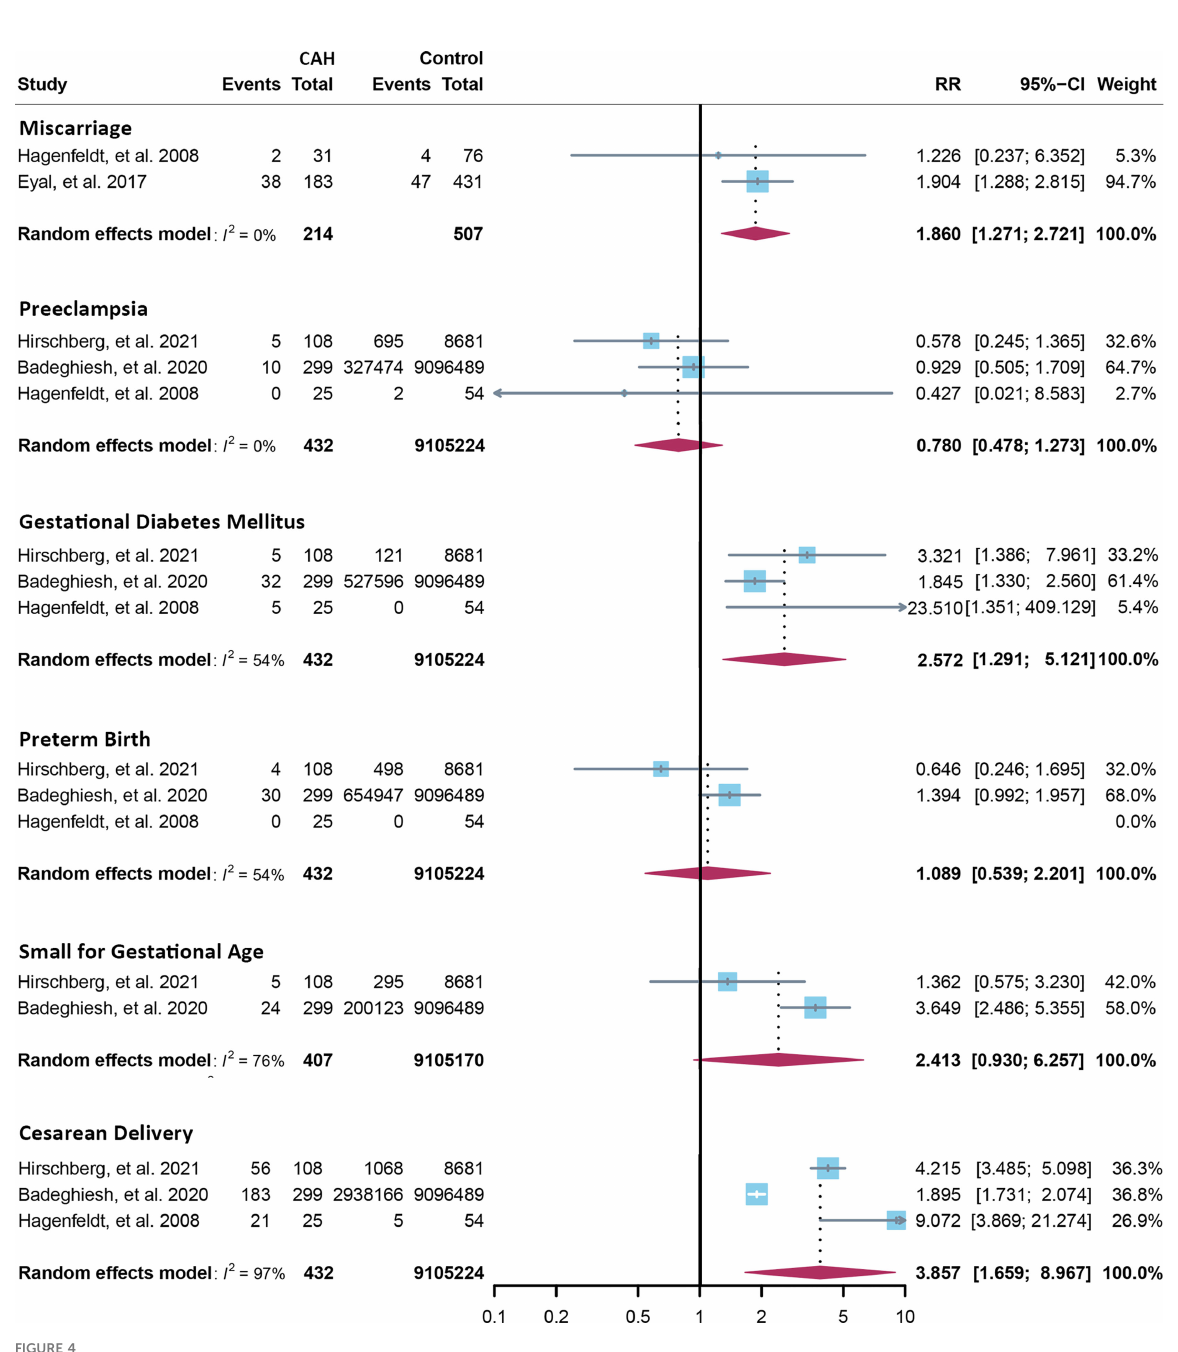
FIGURE 4 Relative risk of pregnancy complications in CAH. CAH, congenital adrenal